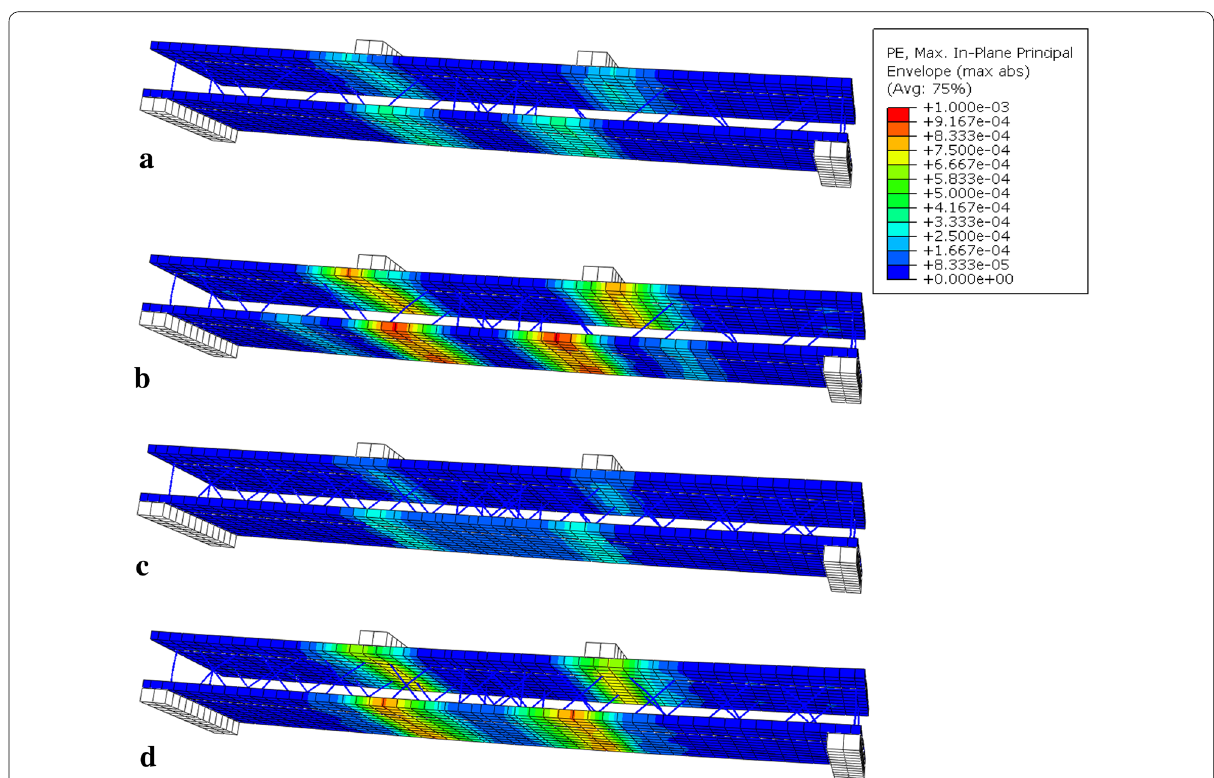
Fig. 19 Crack formation, represented as plastic strain, in the FE model for the single connector configuration (S FE) at a displacement of a 5 mm, b 10 mm and for the double connector configuration (D FE) at a displacement of c 5 mm and d 10 mm. Blue represents no cracking and red represents a fully open crack with no stress